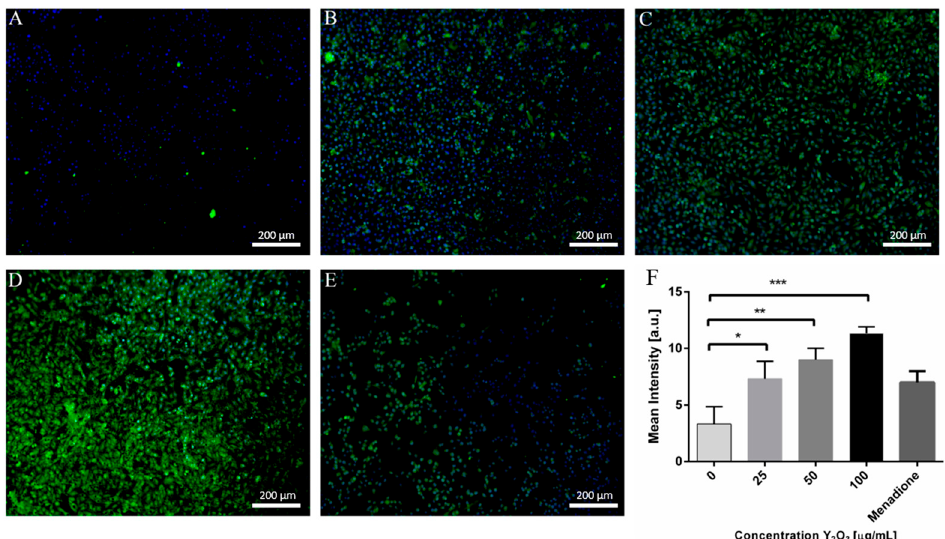
Figure 2. ROS generation by Y 2 O 3 NPs treatment. A375 cells were plated on coverglass, left to adhere for 24 h and incubated for another 24 h with Y 2 O 3 NPs. The cells were stained using a CellROX dye and observed under a fluorescence microscope. ( A – D ) ROS production generated by 0, 25, 50, 100 µg/mL NPs. ( E ) ROS induced by 100 µM menadione. ( F ) Quantification of mean ROS signal intensity (* p < 0.05, ** p < 0.005, *** p < 0.0005).